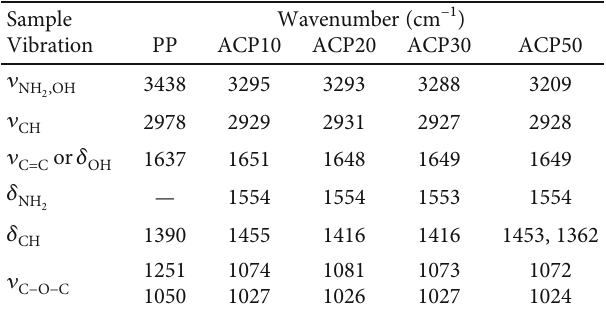
Figure 1: IR spectrum of polyphenols. Table 2: Some main vibrations in the IR spectra of the AGN/CS/PP